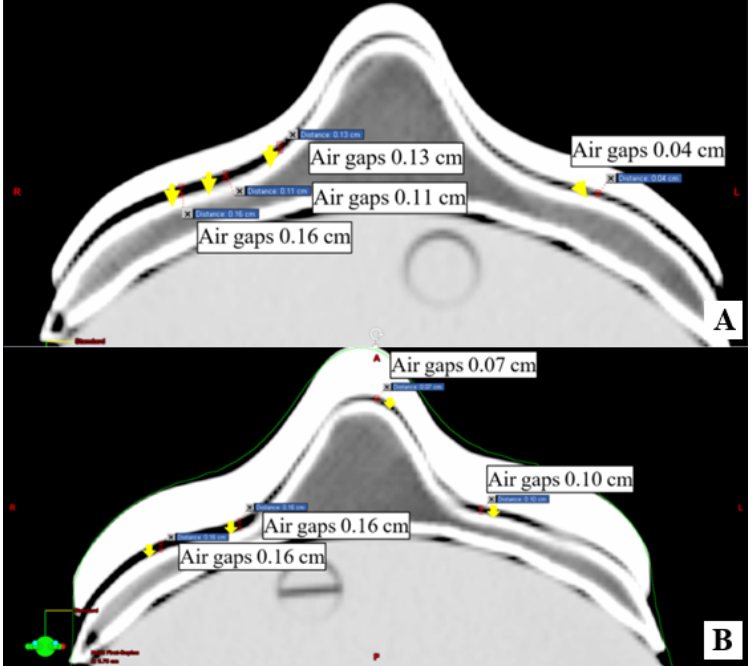
Figure 6. Marked air gaps between patient-specific phantom and each of the 3D-printed boluses: ( A ) 0.5 cm thick bolus; ( B ) 1.0 cm thick